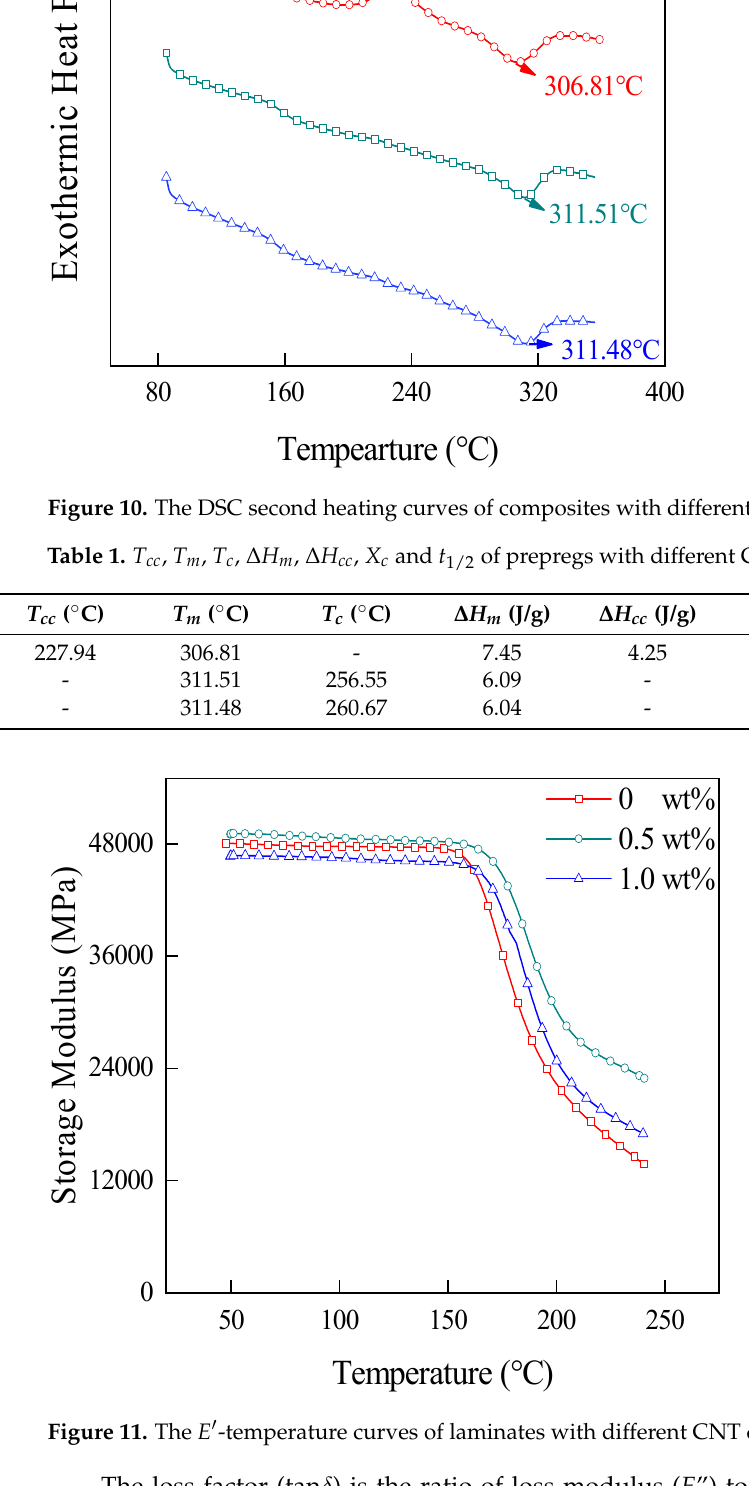
formation. The tan δ peak can reflect the degree of bonding between CF and PEKK, and